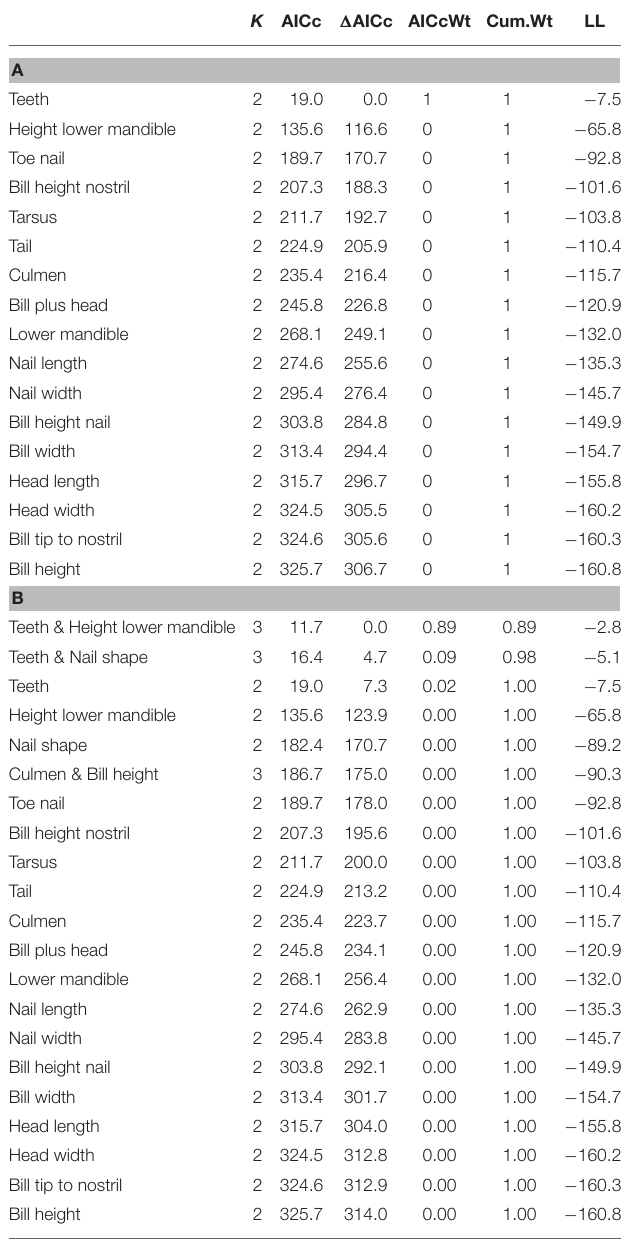
TABLE 7 | AICc-based model selection for the 17 original single variable models (A) and the extended variable set (B) LD1